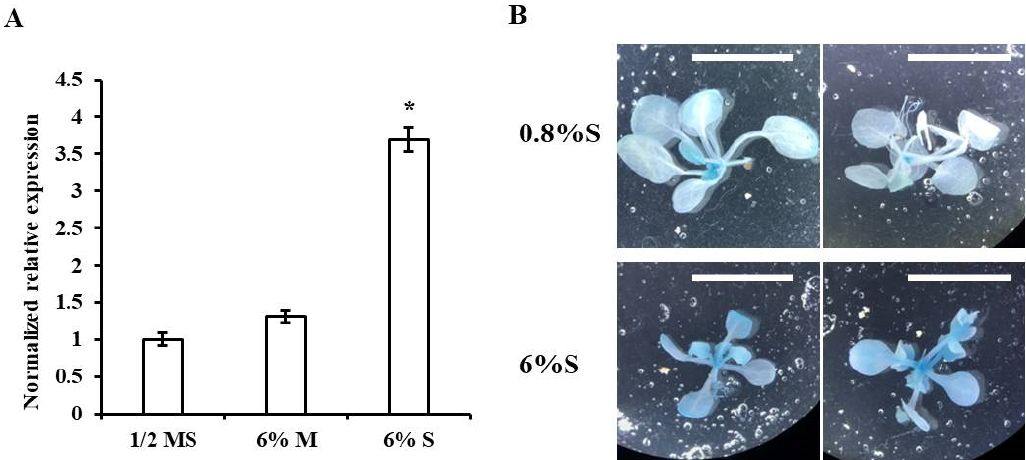
Figure 2. MOS1 expression in response to sugar. ( A ) qRT ‐ PCR analysis of MOS1 expression in 10 ‐ d ‐ old Col ‐ 0 seedlings grown on half ‐ strength MS medium with 0.8% sucrose (S), 6% mannitol (M), or 6% S. Quantification was normalized to ACTIN2 . Error bars indicate the standard error (SE) of two independent biological replicates. The asterisk indicates a significant difference compared with seedlings grown on half ‐ strength MS medium with 0.8% sucrose (one ‐ way ANOVA/Bonferroni p < 0.001). ( B ) Representative images showing the β ‐ glucuronidase activity of the p MOS1::GUS line grown on half ‐ strength MS medium with 0.8% S or 6% S. Scale bars = 1 cm.